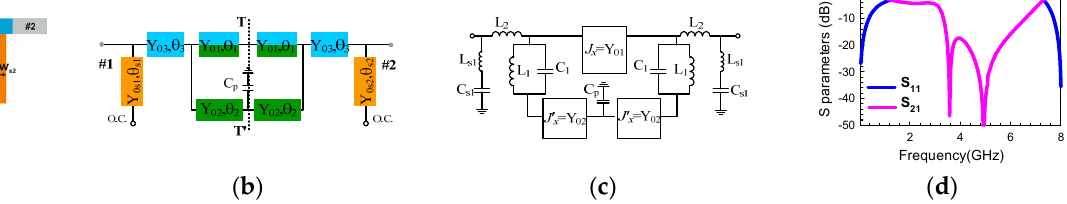
Figure 5. ( a ) A bandstop filter circuit by using a square loop resonator with perturbation element and open-circuited stubs ( b ) TL model ( c ) LE model ( d ) frequency response.